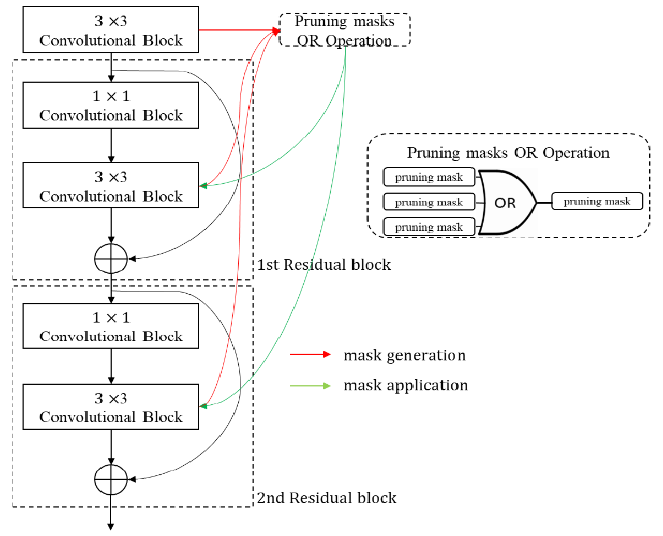
Figure 7. OR method. Figure 7. OR